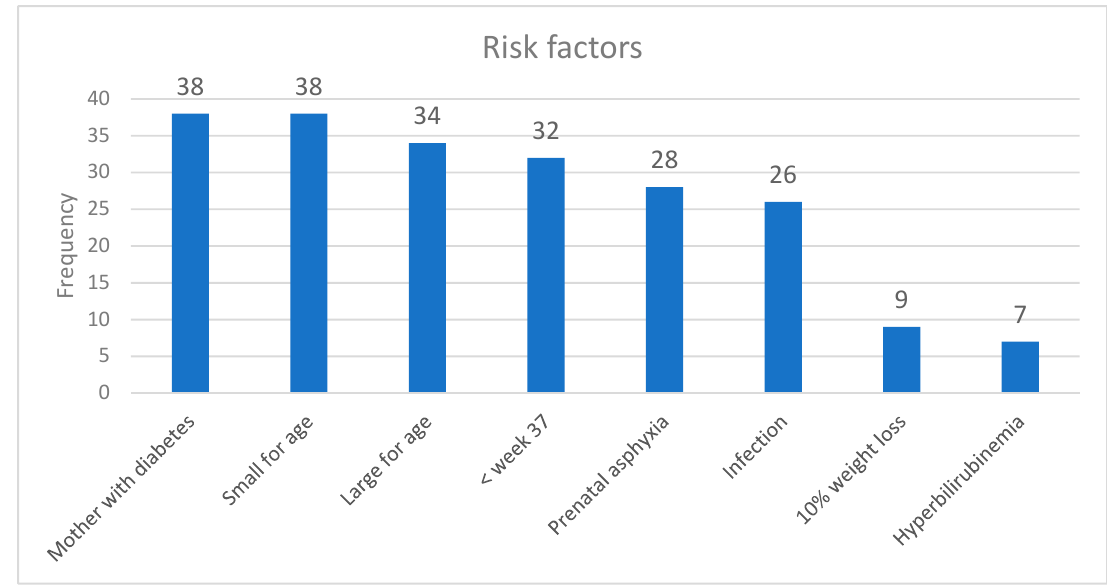
Figure 2. Risk factors for the need for supplemental feeding.